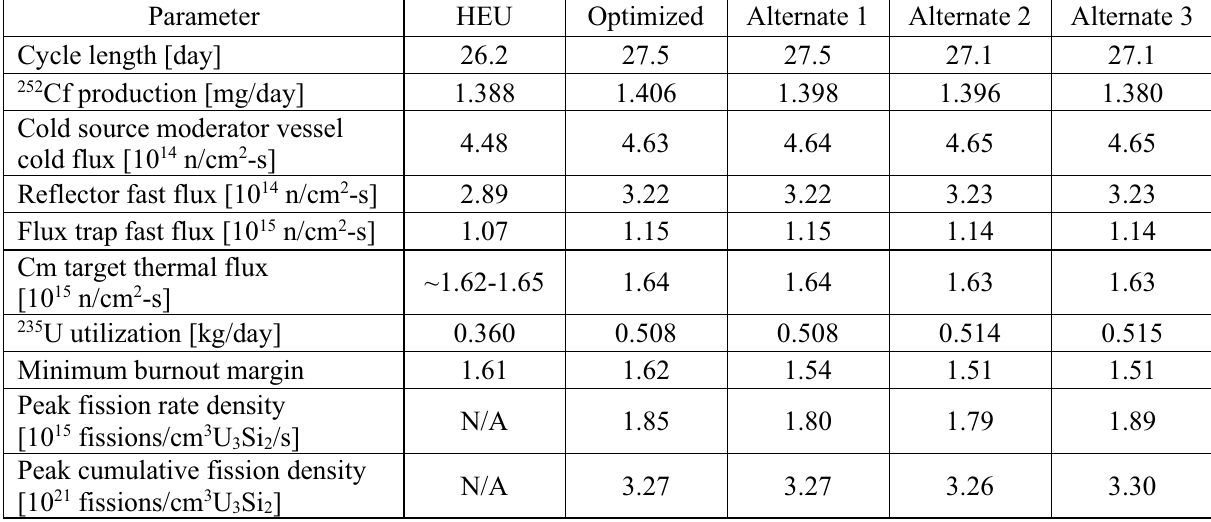
Table II. Conceptual design performance and thermal margin